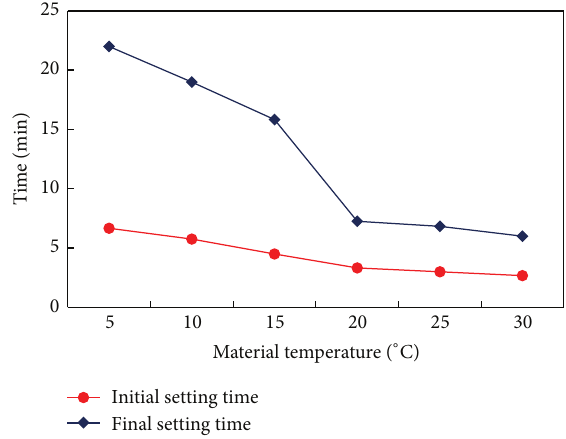
Figure 1: Effect of material temperature on the result of solidifica- tion at an environmental temperature of 20 ∘ C.